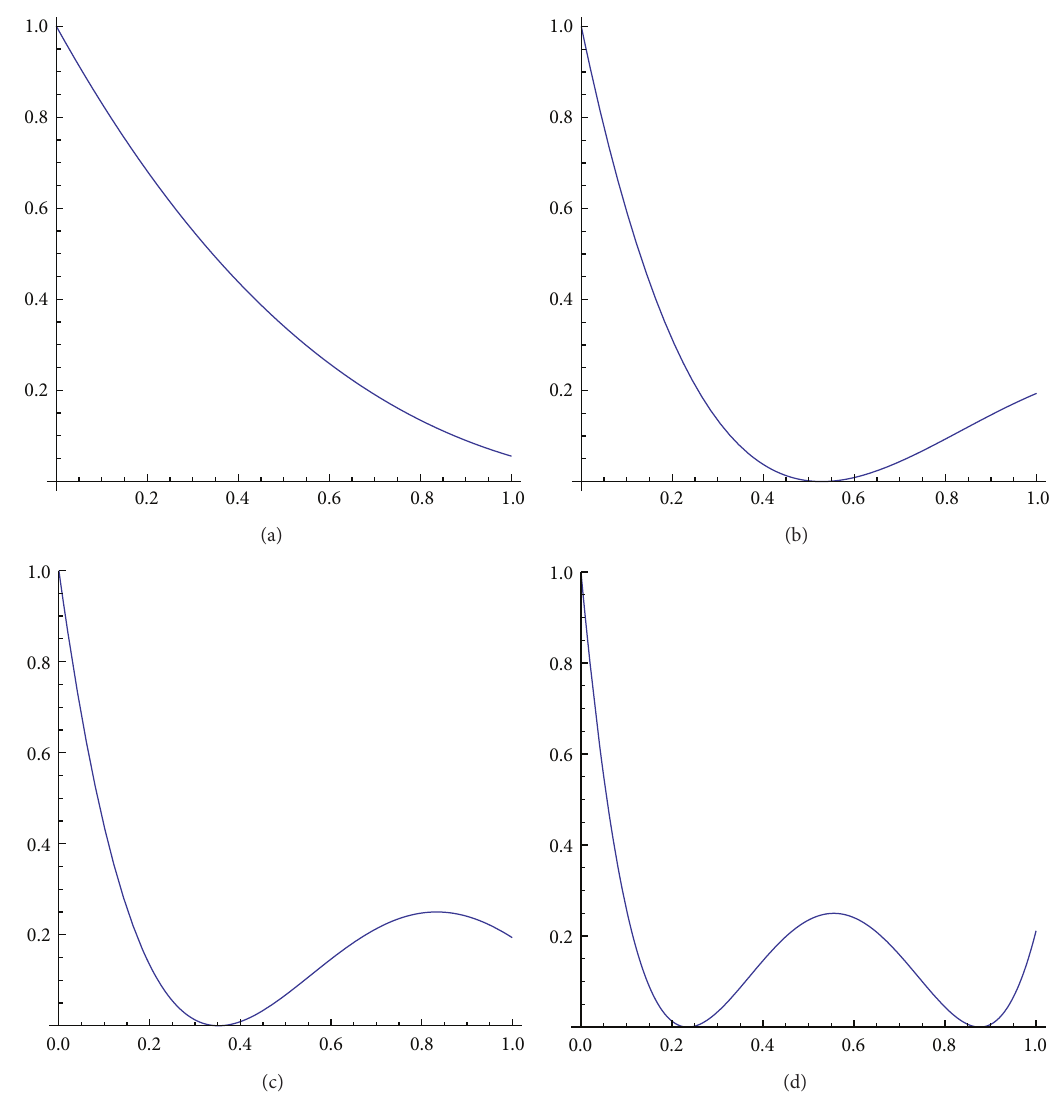
Figure 2: Graphics of the map 𝐹 𝛼,𝛽 for 𝛼 = 1.5 and 𝛽 = 0.3 , 0.8, 1.2, and 1.8 for each